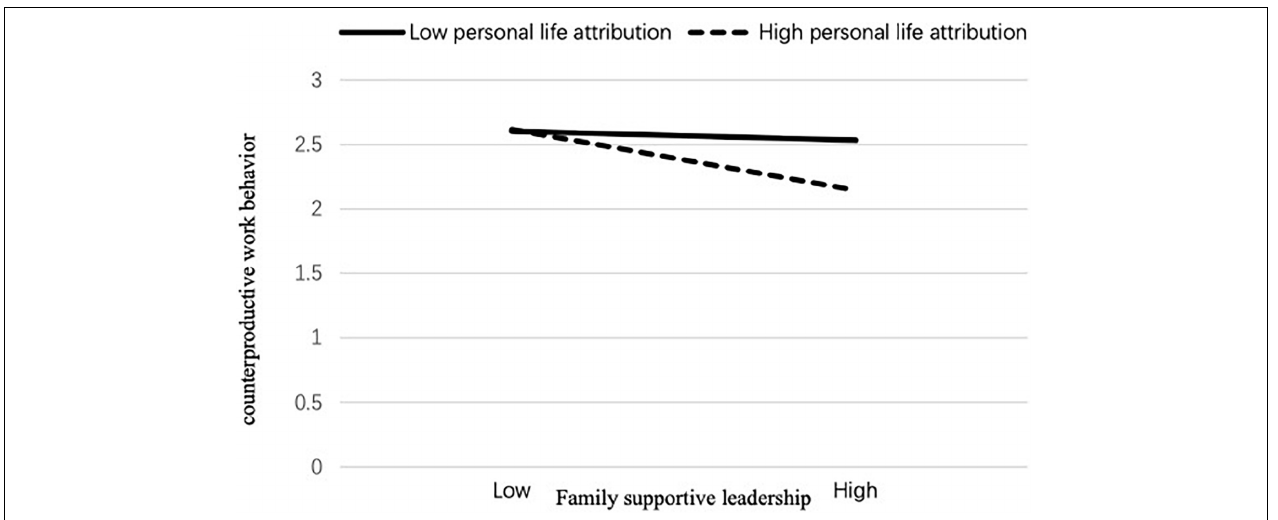
FIGURE 4 | Personal life attribution for family supportive leadership moderates the relationship between supportive leadership and counterproductive work behavior. Five-factor model: family supportive leadership; personal life attribution; work-family conflict; moral disengagement; CWB. Four-factor model: family supportive leadership; personal life attribution; work -family conflict; moral disengagement + CWB. Three-factor model: family supportive leadership; personal life attribution; work -family conflict + moral disengagement + CWB. Two-factor model: family supportive leadership; personal life attribution + work-family conflict + moral disengagement + CWB. Single-factor model: family supportive leadership + personal life attribution + work -family conflict + moral disengagement +